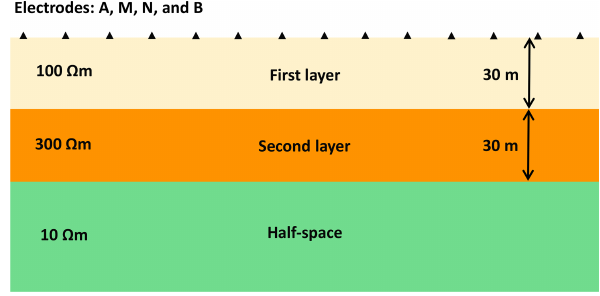
Figure 3. Vertical cross section of a three-layer earth resistivity model used for benchmarking PFLOTRAN results against the ana- lytical